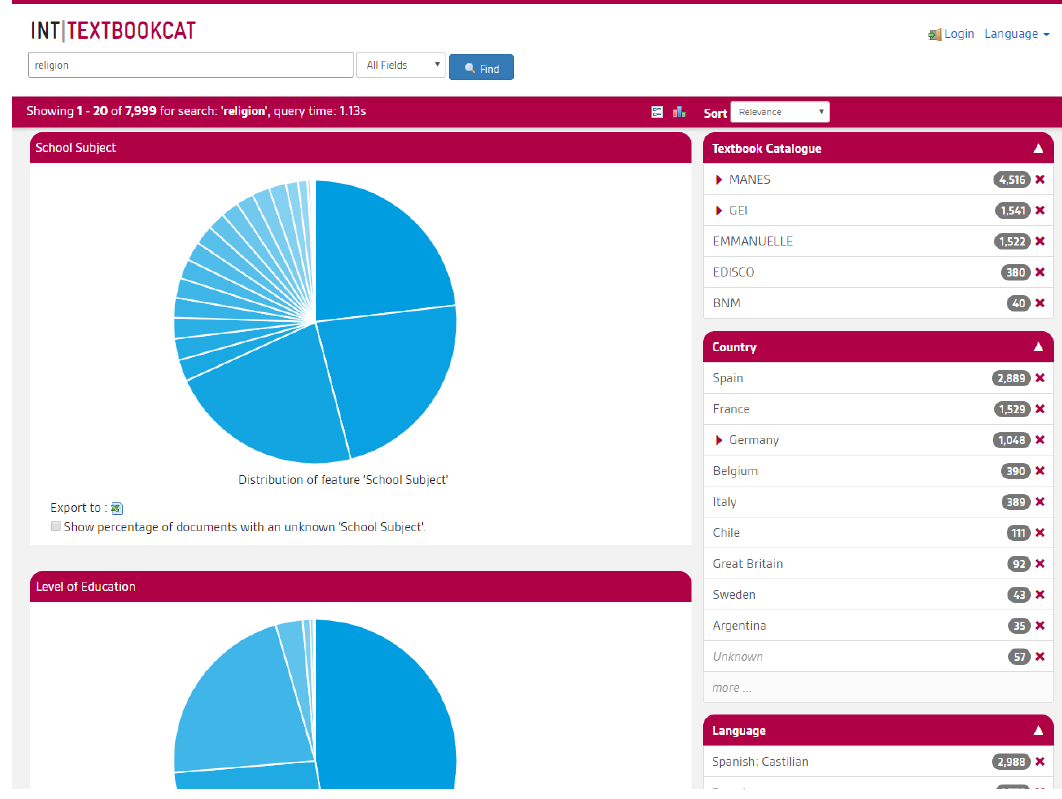
Figure 4. Presentation of the statistics given a query in the International TexbookCat Research